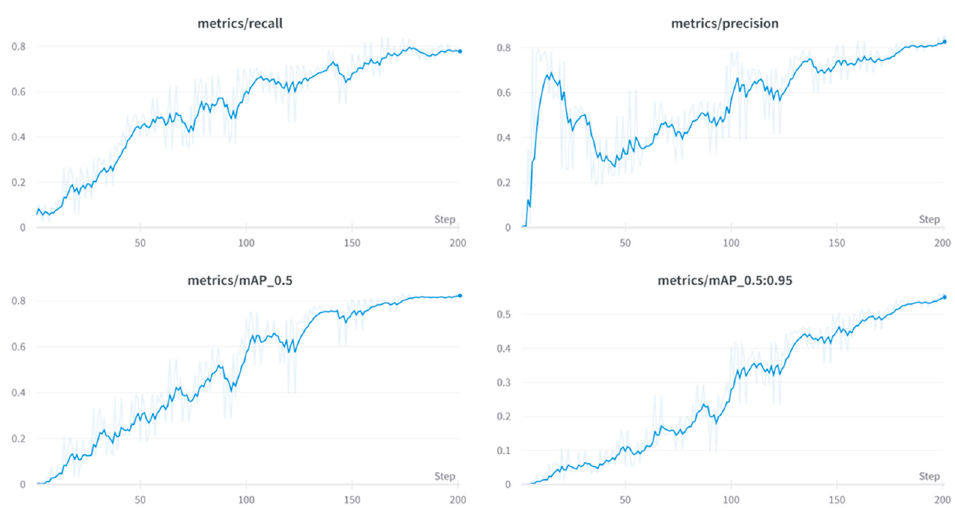
Figure 7. Metrics for training and validation sets; Precision, Recall, mAP@0.5, mAP@0.5:0.95 .